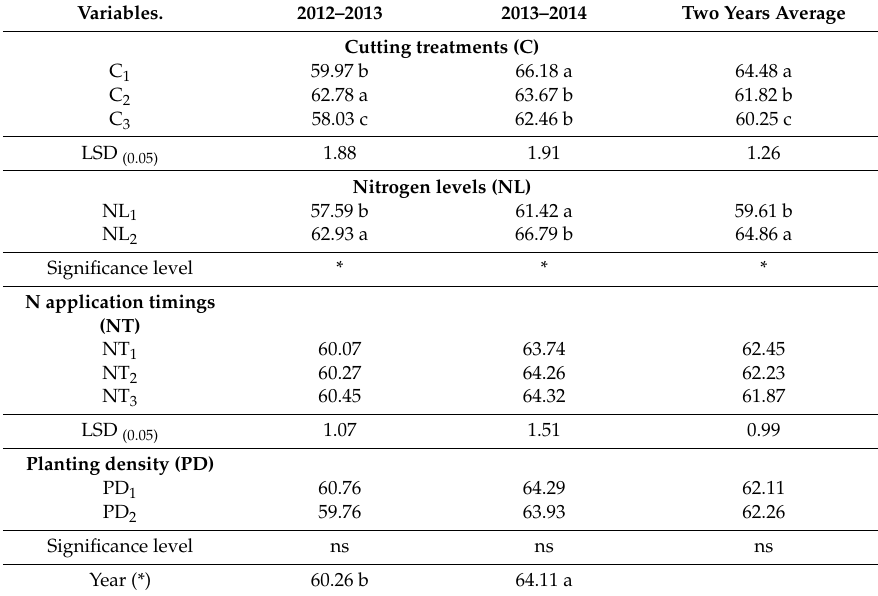
Table 8. Canola glucosinolates content ( µ mol g − 1 ) as a ff ected by cutting treatments, nitrogen levels and application timings under varying planting densities.